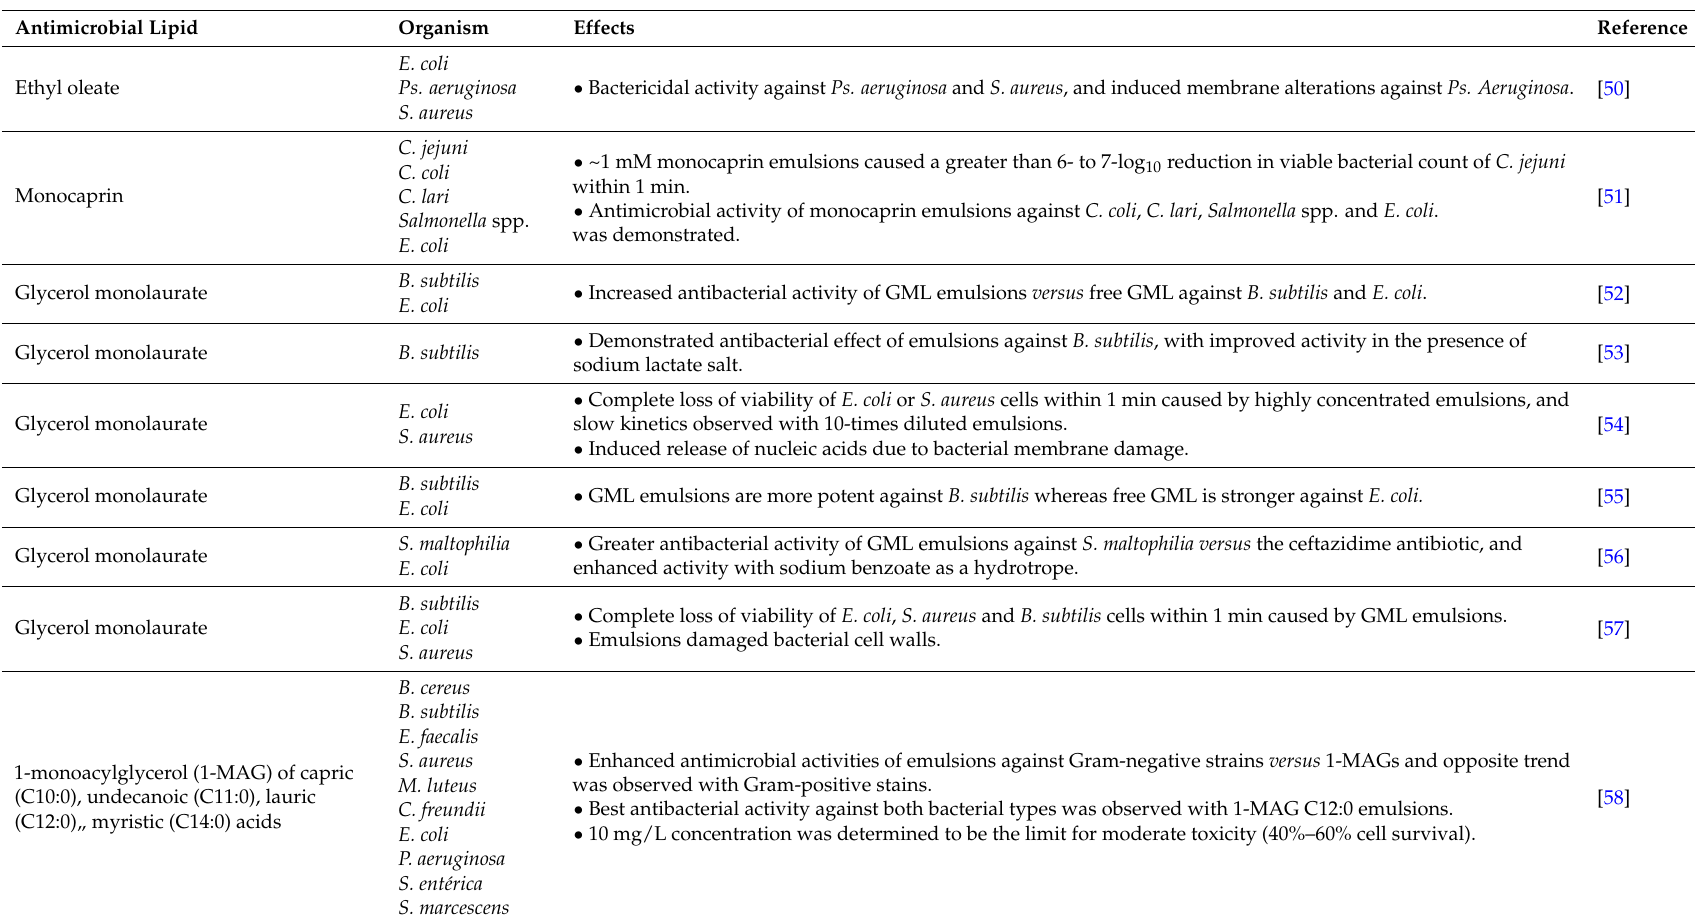
Table 1. Past studies involving antibacterial properties of monoglyceride